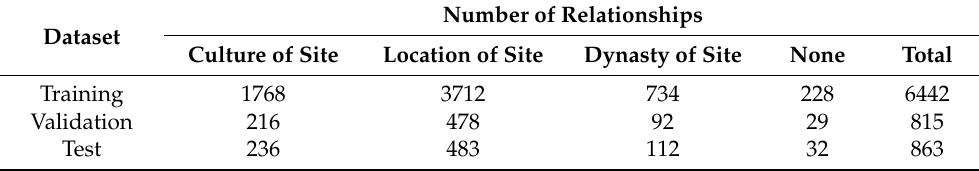
Table 4. Statistics of relationships in the